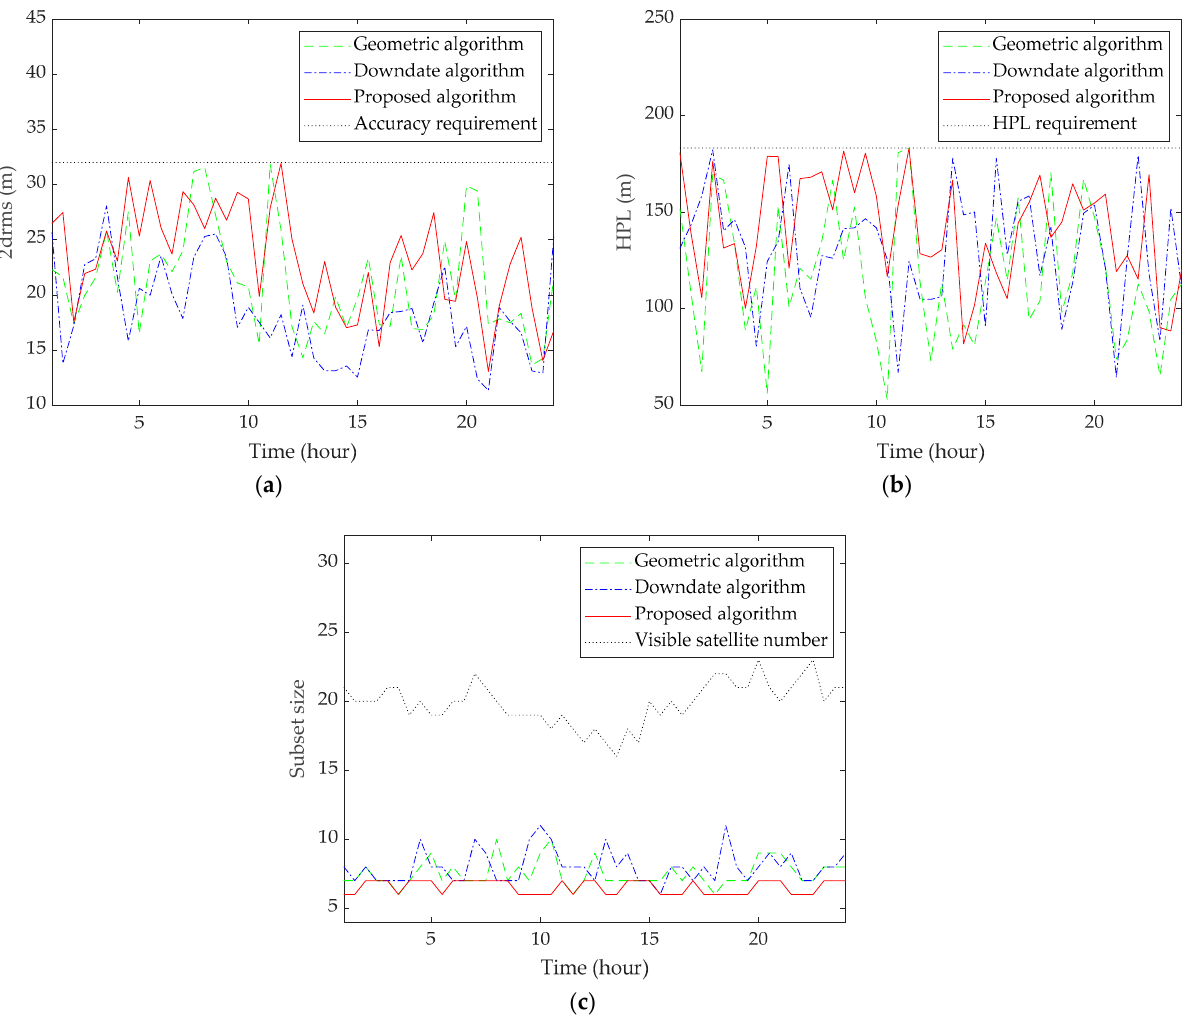
Figure 7. 2drms, HPL and subset size of the final subset constructed by each algorithm under LNAV requirement. ( a ) 2drms value; ( b ) HPL value; ( c ) Subset size.